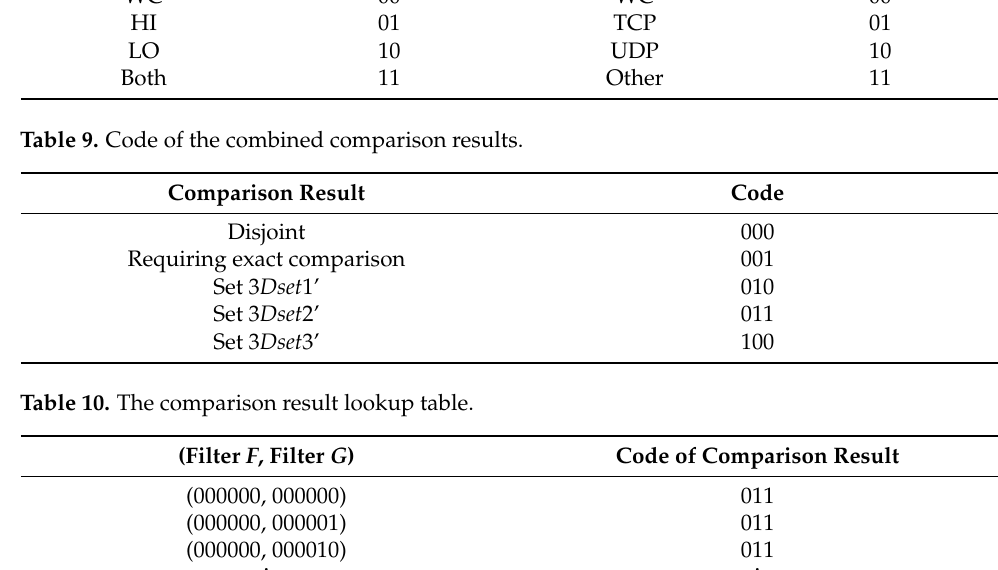
Table 8. Code of port and protocol field.